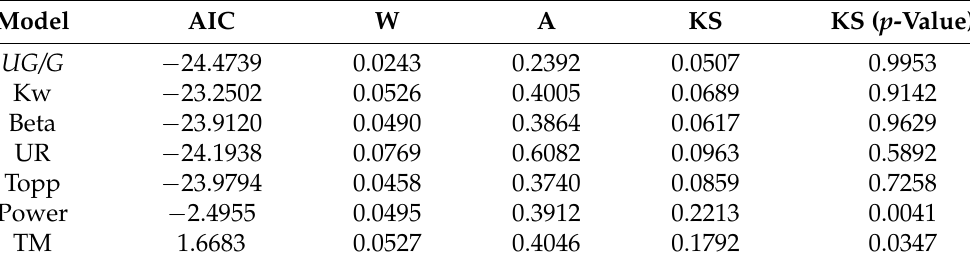
Table 9. AIC, W, A, KS, and KS ( p -value) values for the trade share data